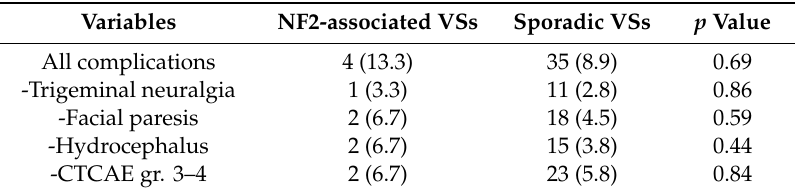
Table 3. Summary of radiation-related adverse events before matching. * Values of p < 0.05 are considered statistically significant. NF2 = neurofibromatosis type 2; VS = vestibular schwannoma; CTCAE = Common Terminology Criteria for Adverse Events version 4.0.